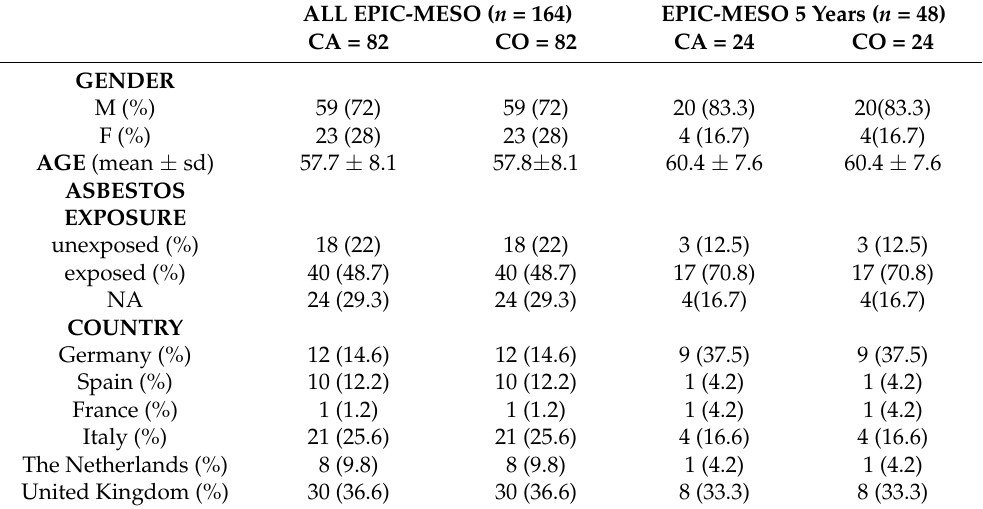
Table 1. Descriptive table of the samples included in the EPIC-MESO study at recruitment. ALL EPIC-MESO indicates the sequenced pre-MPM cases and matched controls. EPIC-MESO 5 years includes the subgroup of preclinical MPM collected within five years prior to MPM diagnosis and their matched